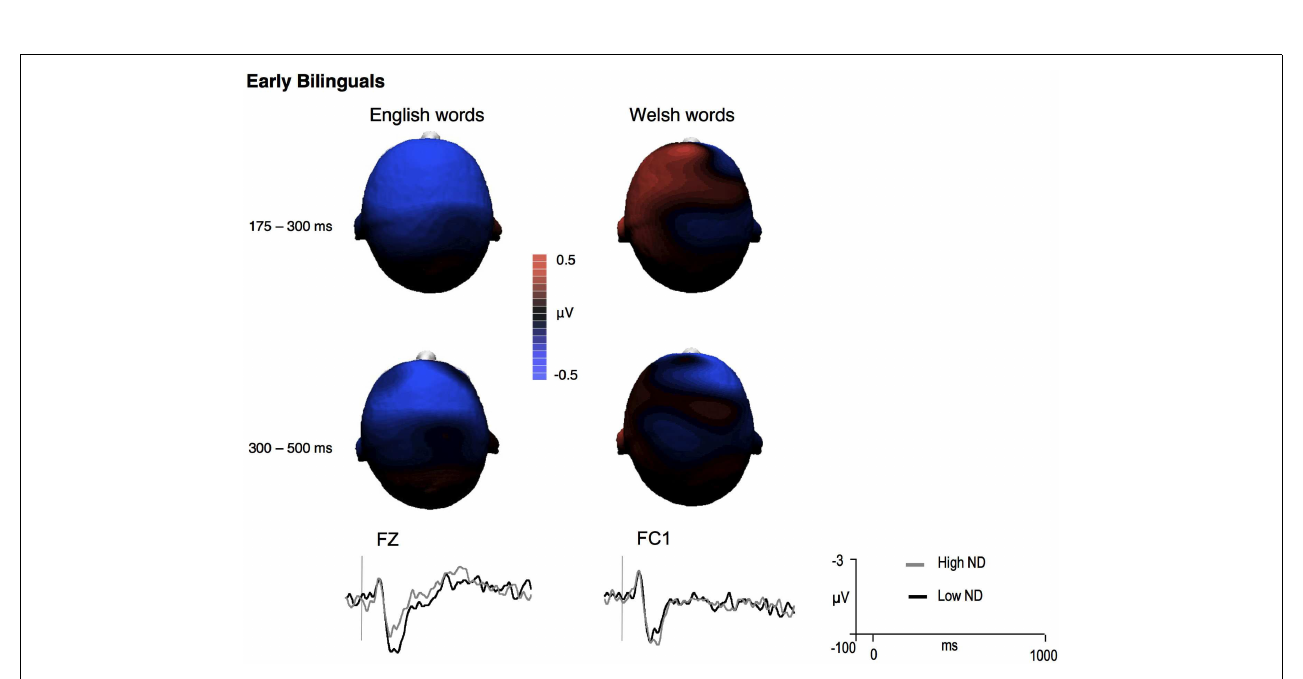
the 175–300ms time window, as no significant cross-language ND effects were observed during the 300–500ms time window; negative is plotted